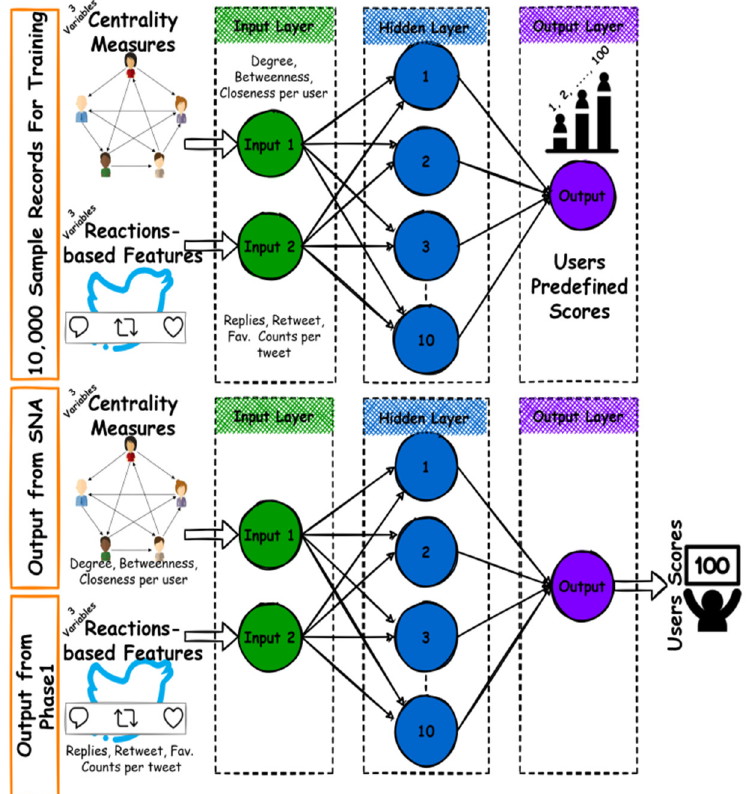
Figure 4. The training and scoring processes of the constructed ANN.